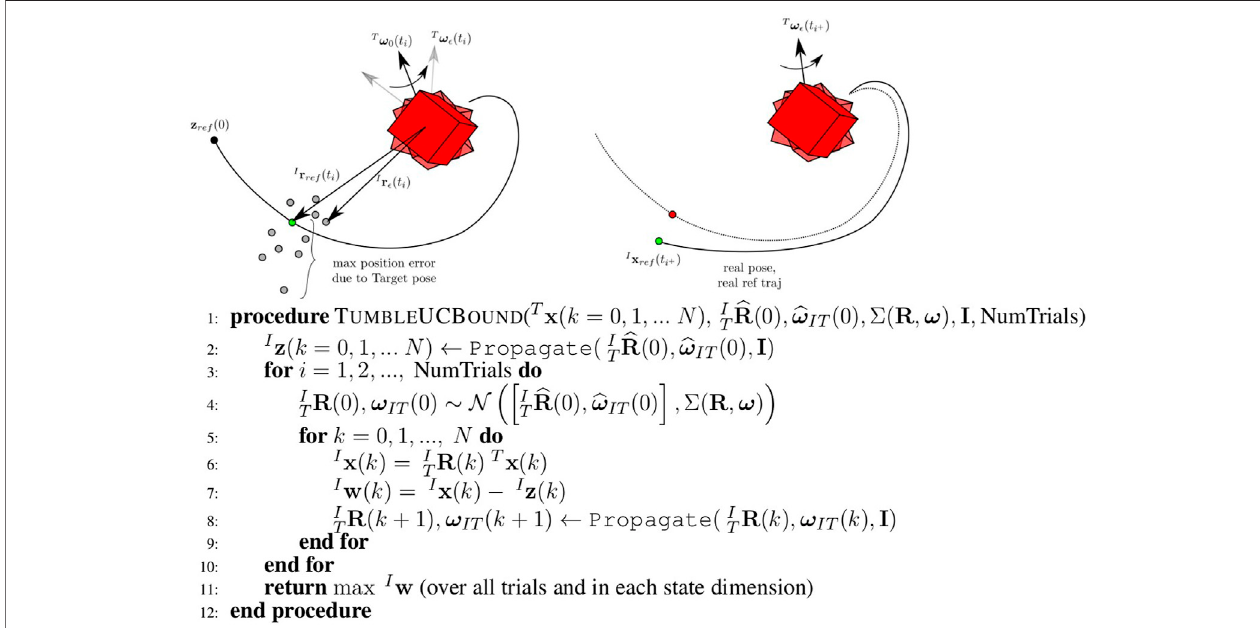
FIGURE 6 | The Propagate step of the uncertainty bound procedure (left) . Many Monte Carlo runs over potential initial conditions and parameters for the Target resultinmanypossiblereferencetrajectoryupdatesfrom[ t 0 , t f ].Ateachpointintime,thereisamaximumpossibleerrorfromthenominalreferencetrajectory.Areference trajectory update resulting from a pose update (right) . When new Target pose estimates are available, T x ref can be repropagated in the inertial frame. The algorithm to computetheuncertaintybound fortubeMPCisshown below.Themaximumdisturbancemagnitudesarefoundover thecourse ofanumber ofMonte Carlotrials.